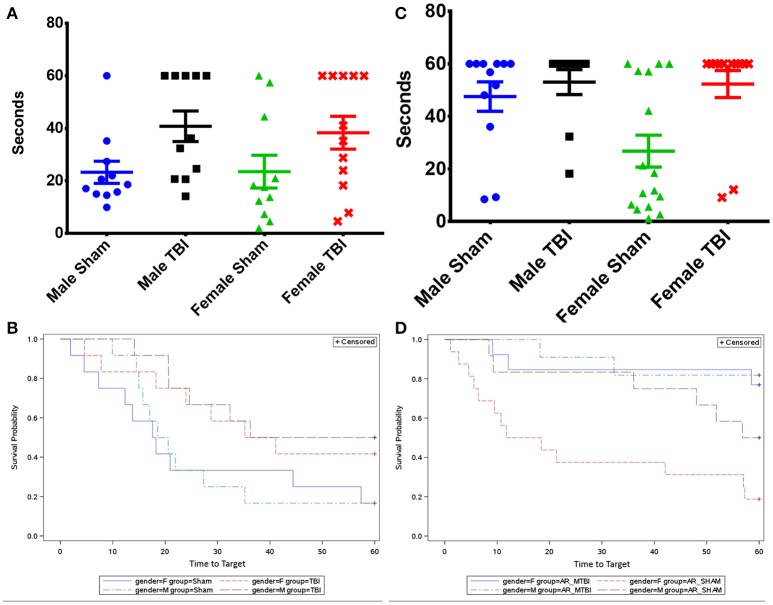
(A) Evaluation of spatial memory retention (probe) using the Barnes maze on days 8–14 after last mTBI in young mice. (B) Survival analysis chart of the time to find the target hole in the Barnes maze probe trial. (C) Evaluation of spatial memory retention (probe) using the Barnes maze on days 8–14 after last mTBI in aged mice. (D) Survival analysis chart of the time to find the target hole in the Barnes maze probe trial. Bars represent standard error but are biased by ceiling effects within the data.